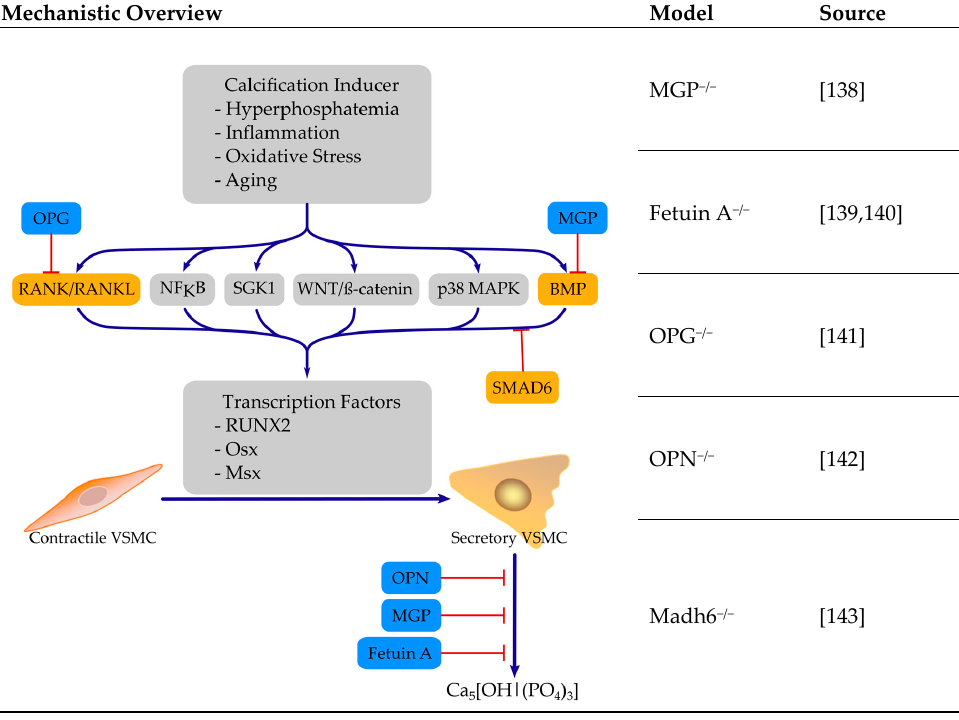
Figure 2. Selected mice models with absent or dysfunctional calcification inhibiting peptides and their mechanisms. Red T-arrows: inhibition, blue arrows: pathway. References: [138–143].